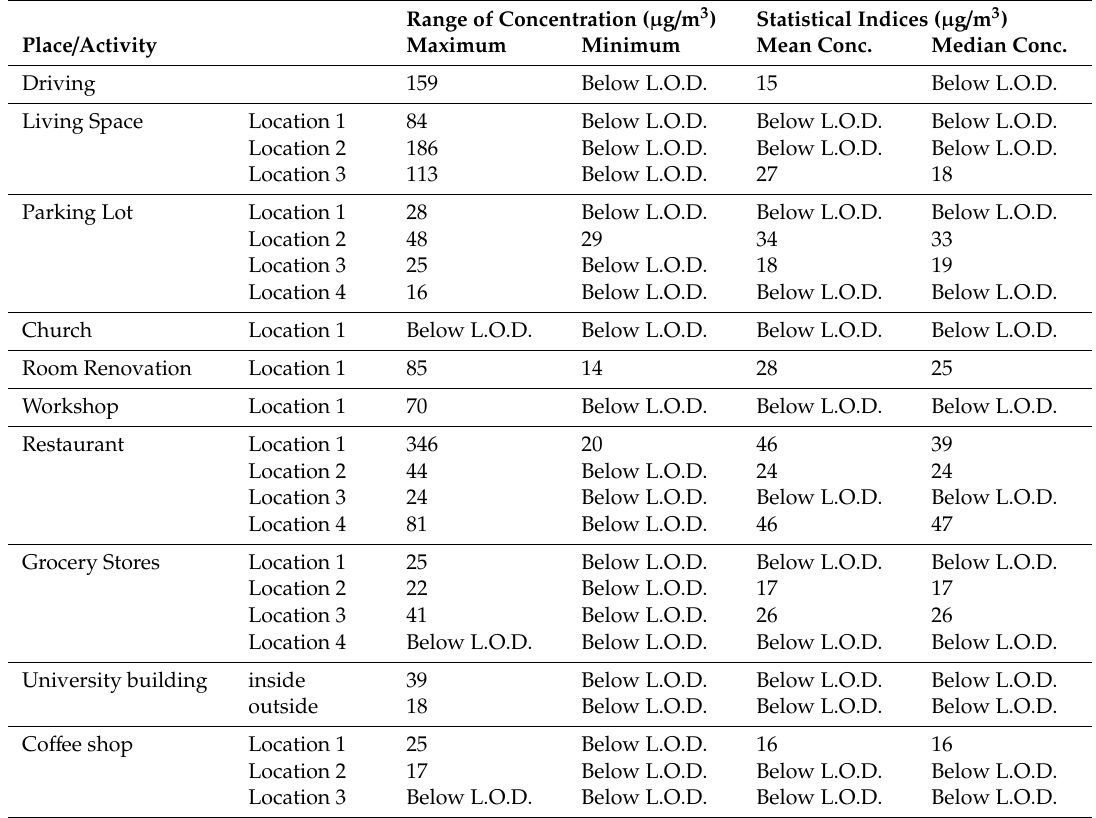
Table 1. Summary of results for locations